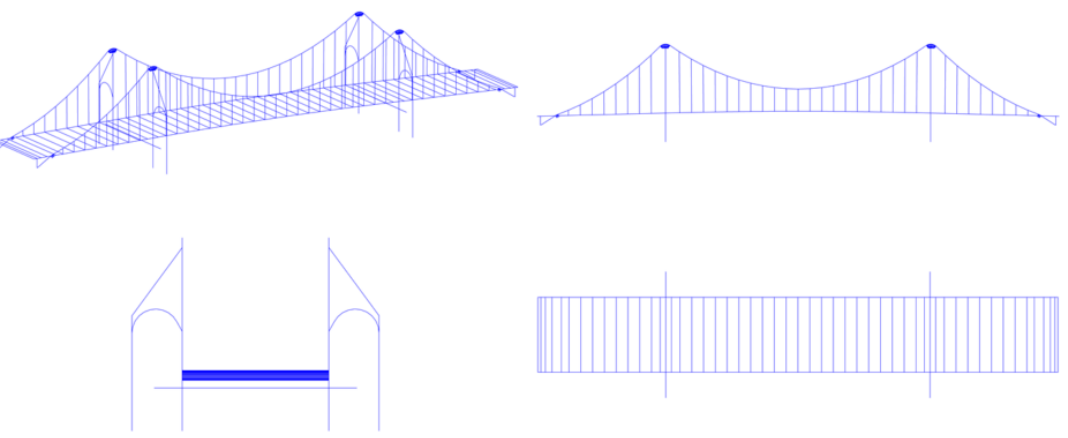
Figure 7. Spatial FE mode of the Hunan Road Bridge.